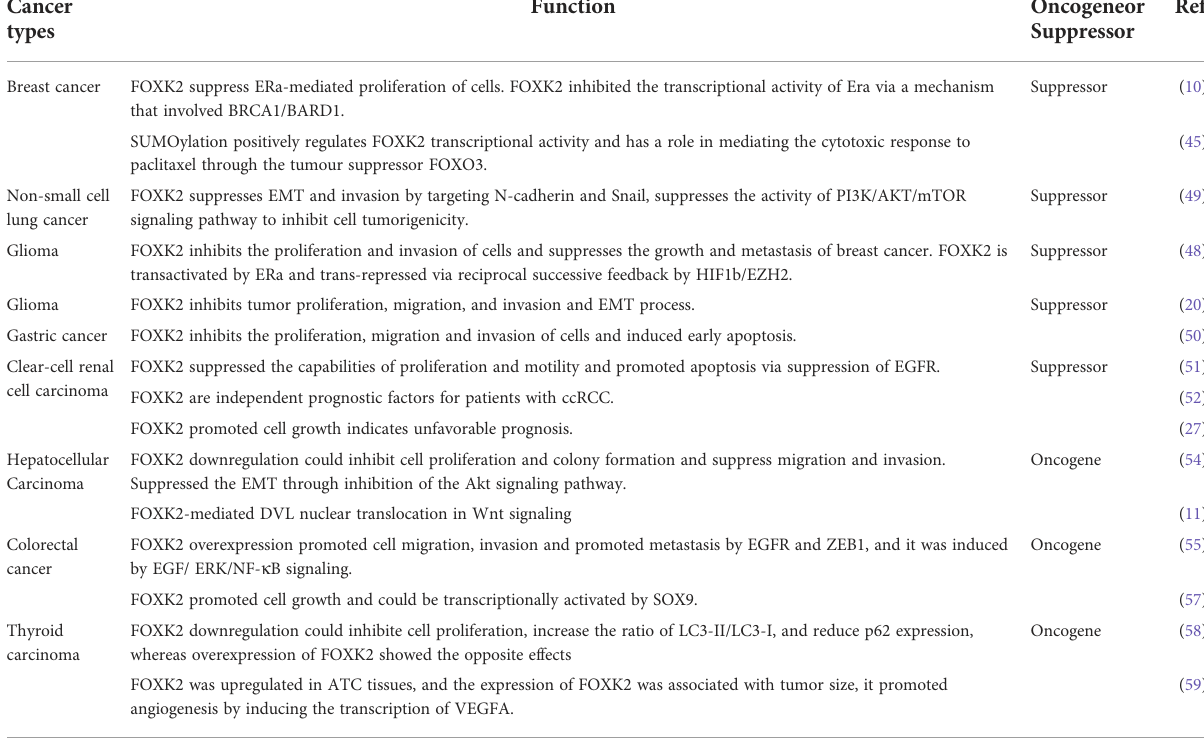
TABLE 3 Functional roles of FOXK2 pathway in different types of cancer. Cancer